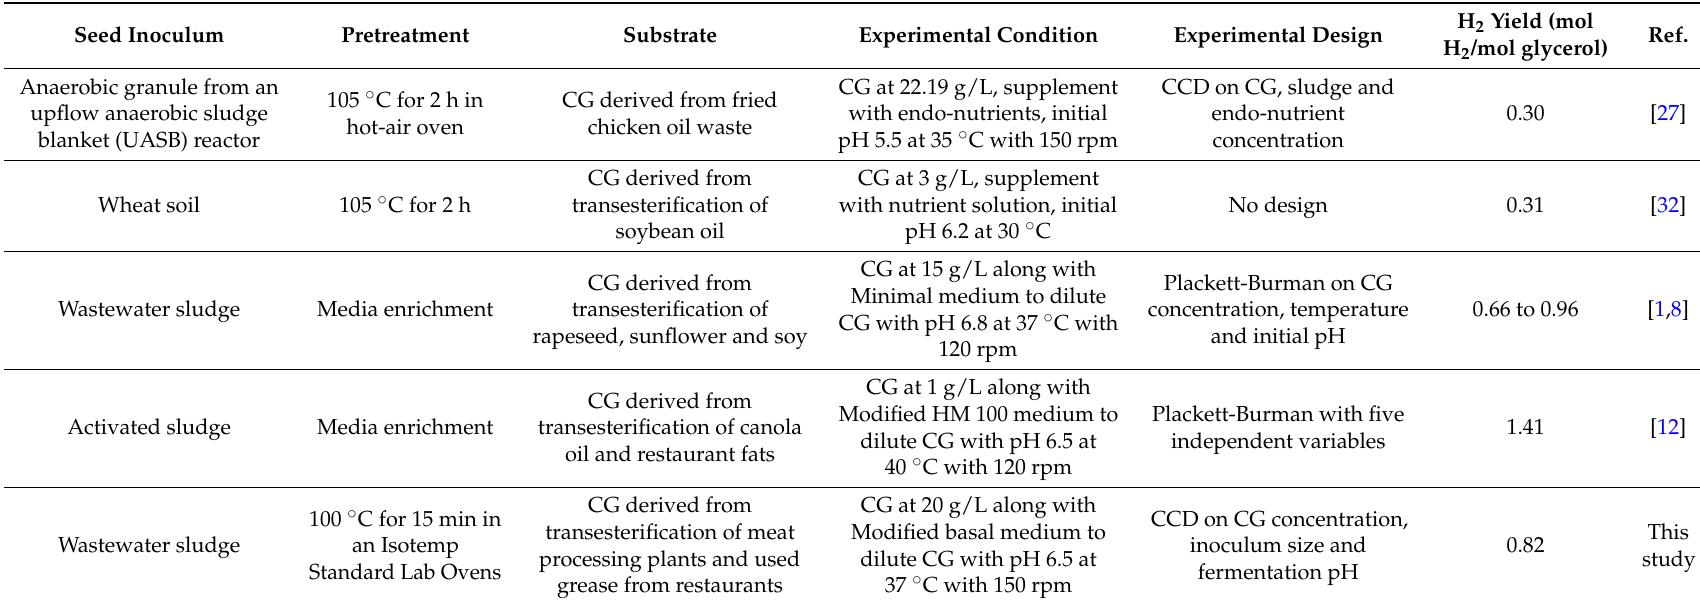
Table 4. Hydrogen yield comparison across mixed-culture studies using crude glycerol as